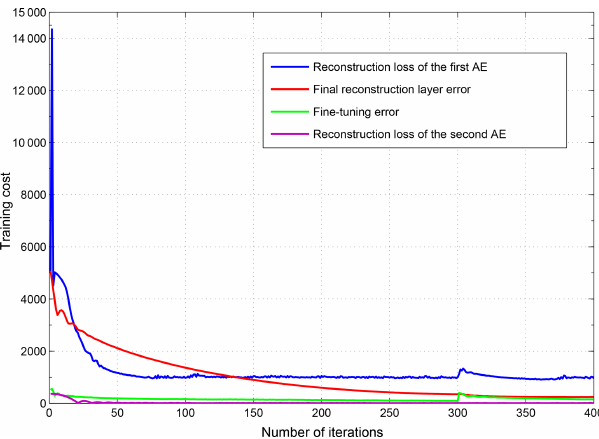
Figure 5. Training cost of each process.